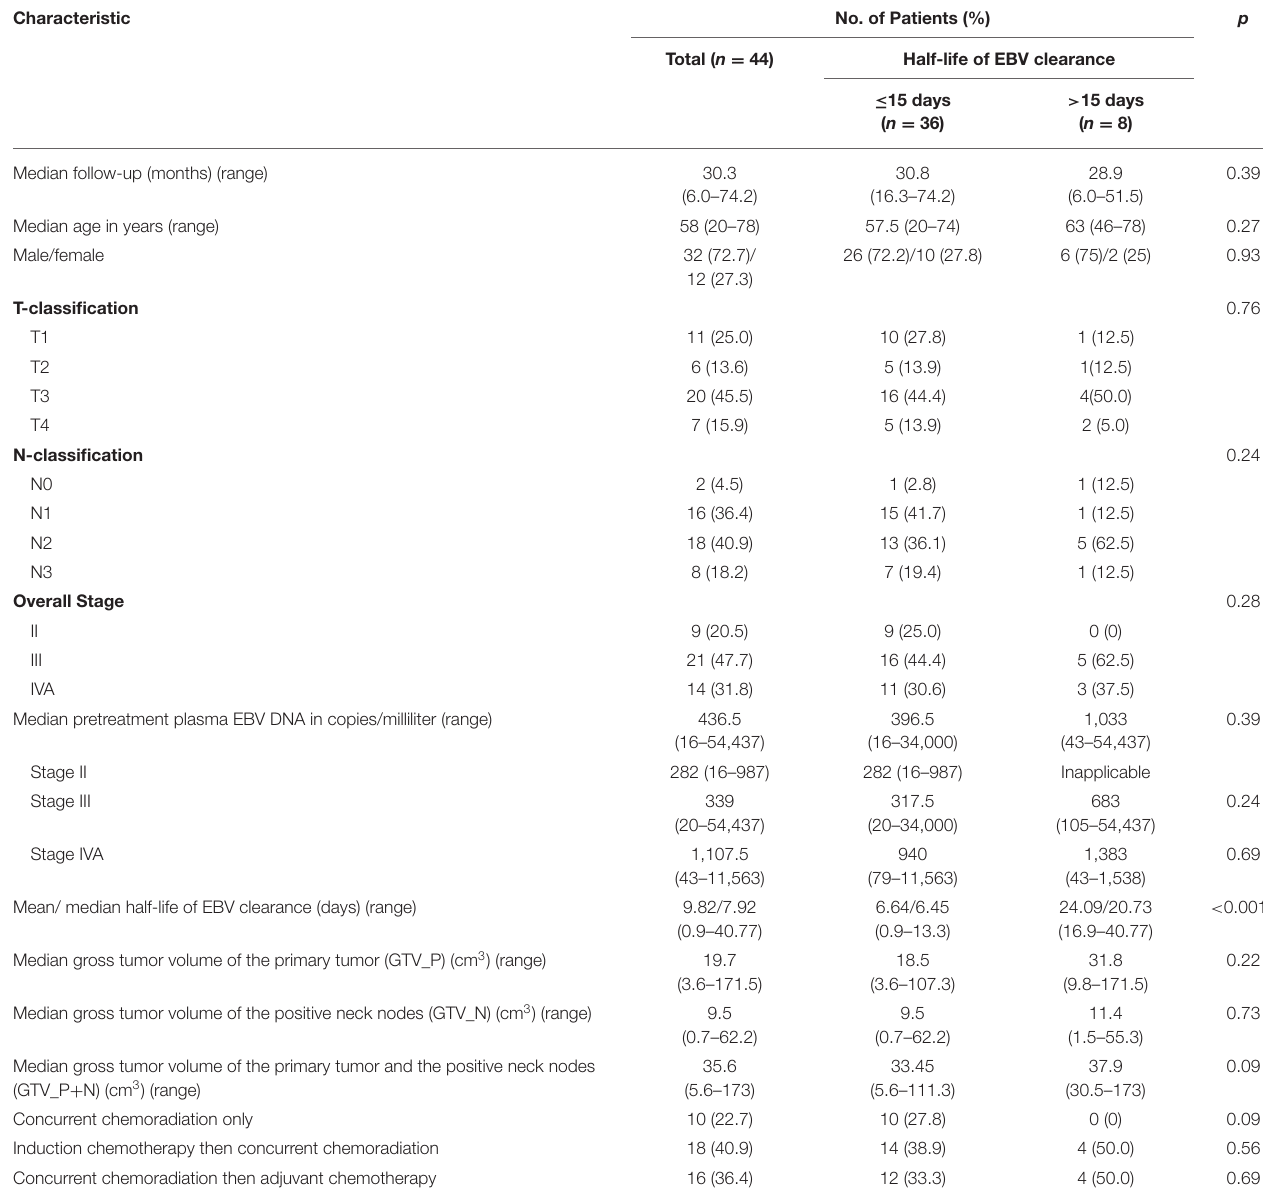
TABLE 2 | Patient baseline characteristics stratified by half-life clearance of plasma EBV DNA.